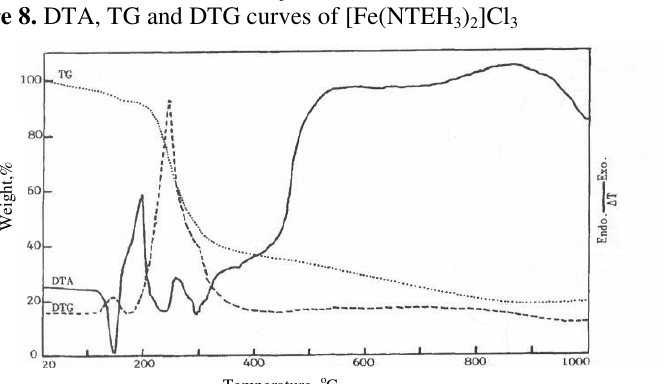
Figure 9 . DAT TG and curves of Ru(NT EH